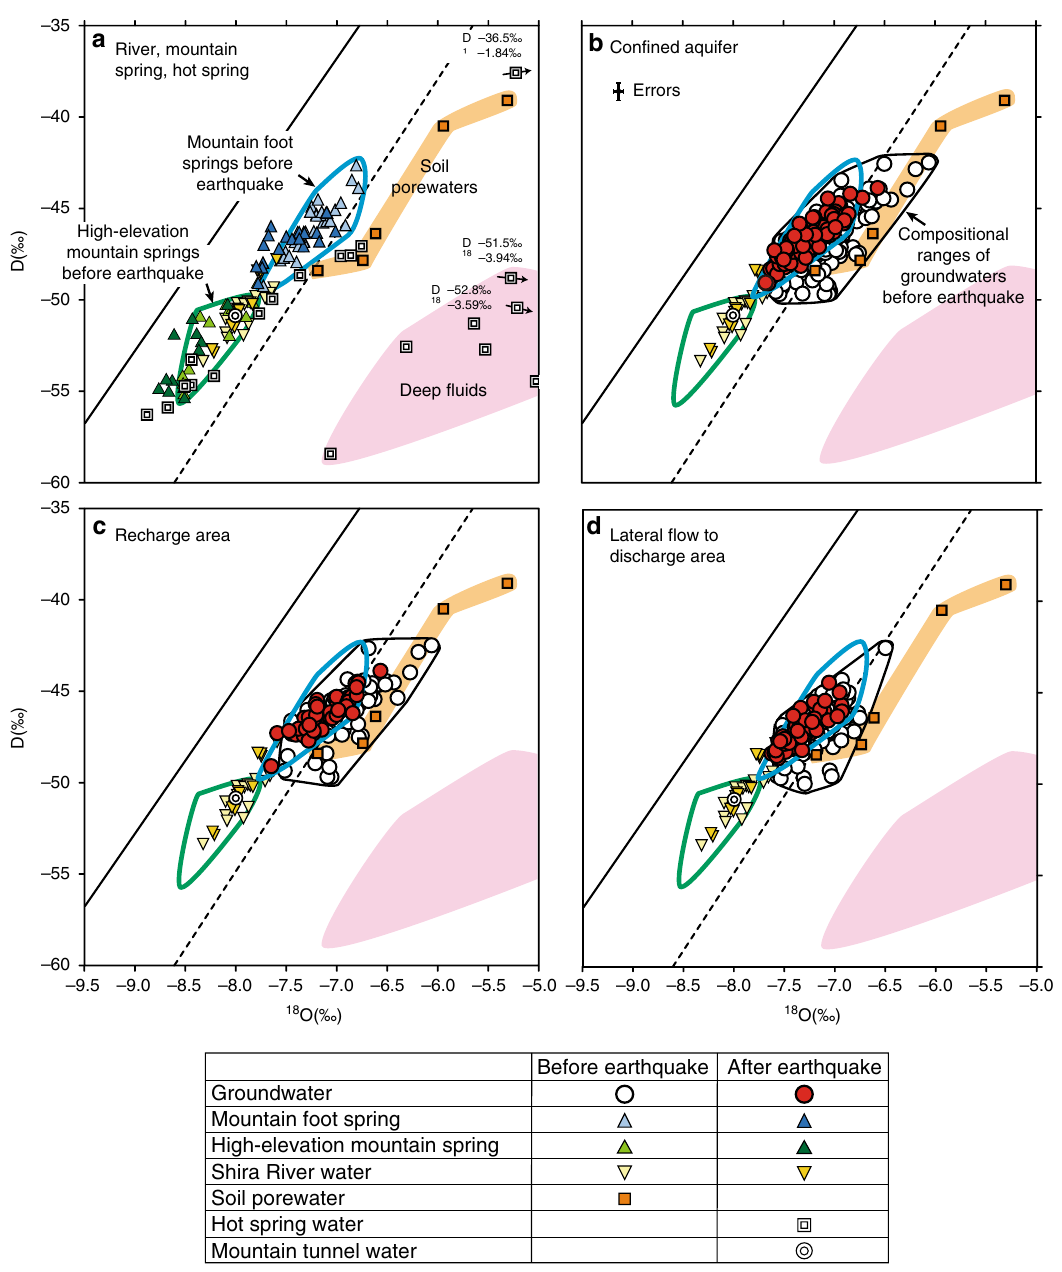
Fig. 3 Coseismic changes in stable isotope ratios. a Oxygen and hydrogen stable isotope ratios showing compositional changes before (April 2011 to July 2011) and after (August 2016 to May 2017) the main shock for river and spring waters for the samples from various seasons. Compositions of hot spring waters and mountain aquifer water from ongoing tunnel construction for the samples collected after the main shock are also plotted. Springs (blue and green triangles) and river (yellow triangle) water samples obtained after the earthquake are shown in darker colors than samples from before the earthquake. b Compositional changes before (November 2009 to November 2011) and after (June 2016 to December 2017) the main shock for con fi ned groundwaters for the samples from various seasons. c , d Compositional changes of groundwaters for recharge and lateral fl ow to discharge areas, respectively. Samples from all seasons for both aquifers (uncon fi ned and con fi ned aquifers) are plotted. The two local meteoric water lines are the same as in Fig. 2. In b – d, groundwater samples after the earthquake are shown in red, while those before the earthquake are shown in white. Errors are shown in Fig.